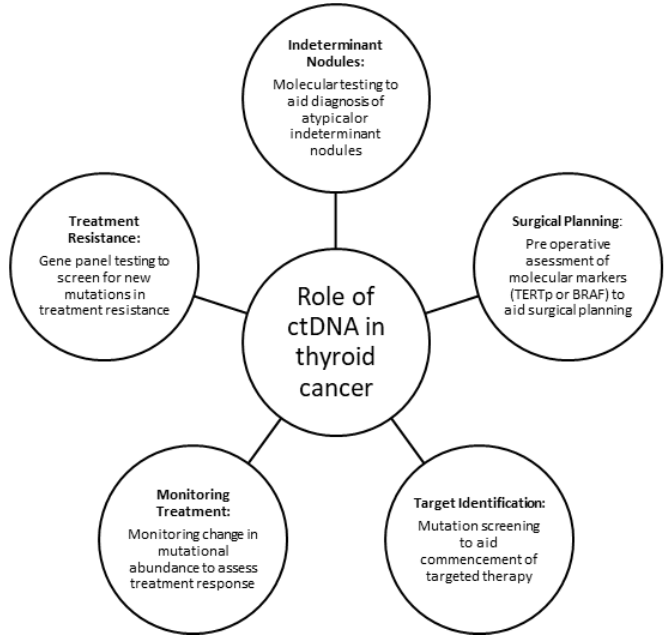
Figure 2. Potential role of liquid biopsy in thyroid cancer.